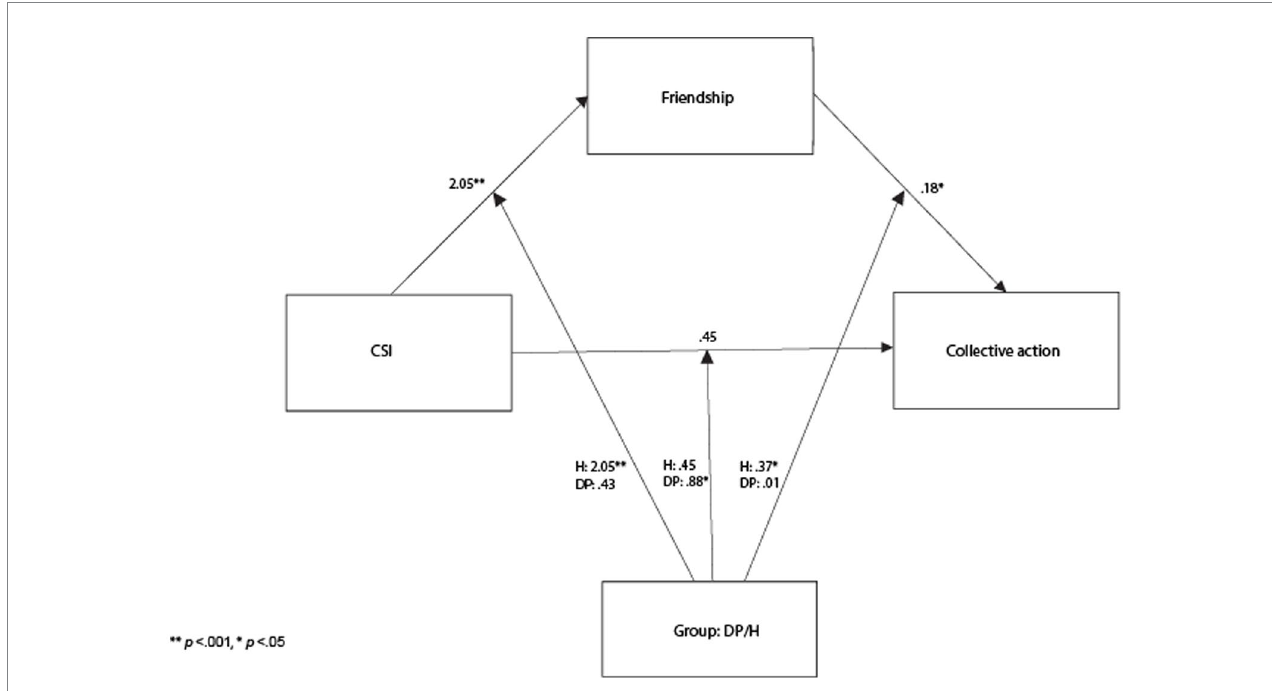
FIGURE 2 Moderated mediation